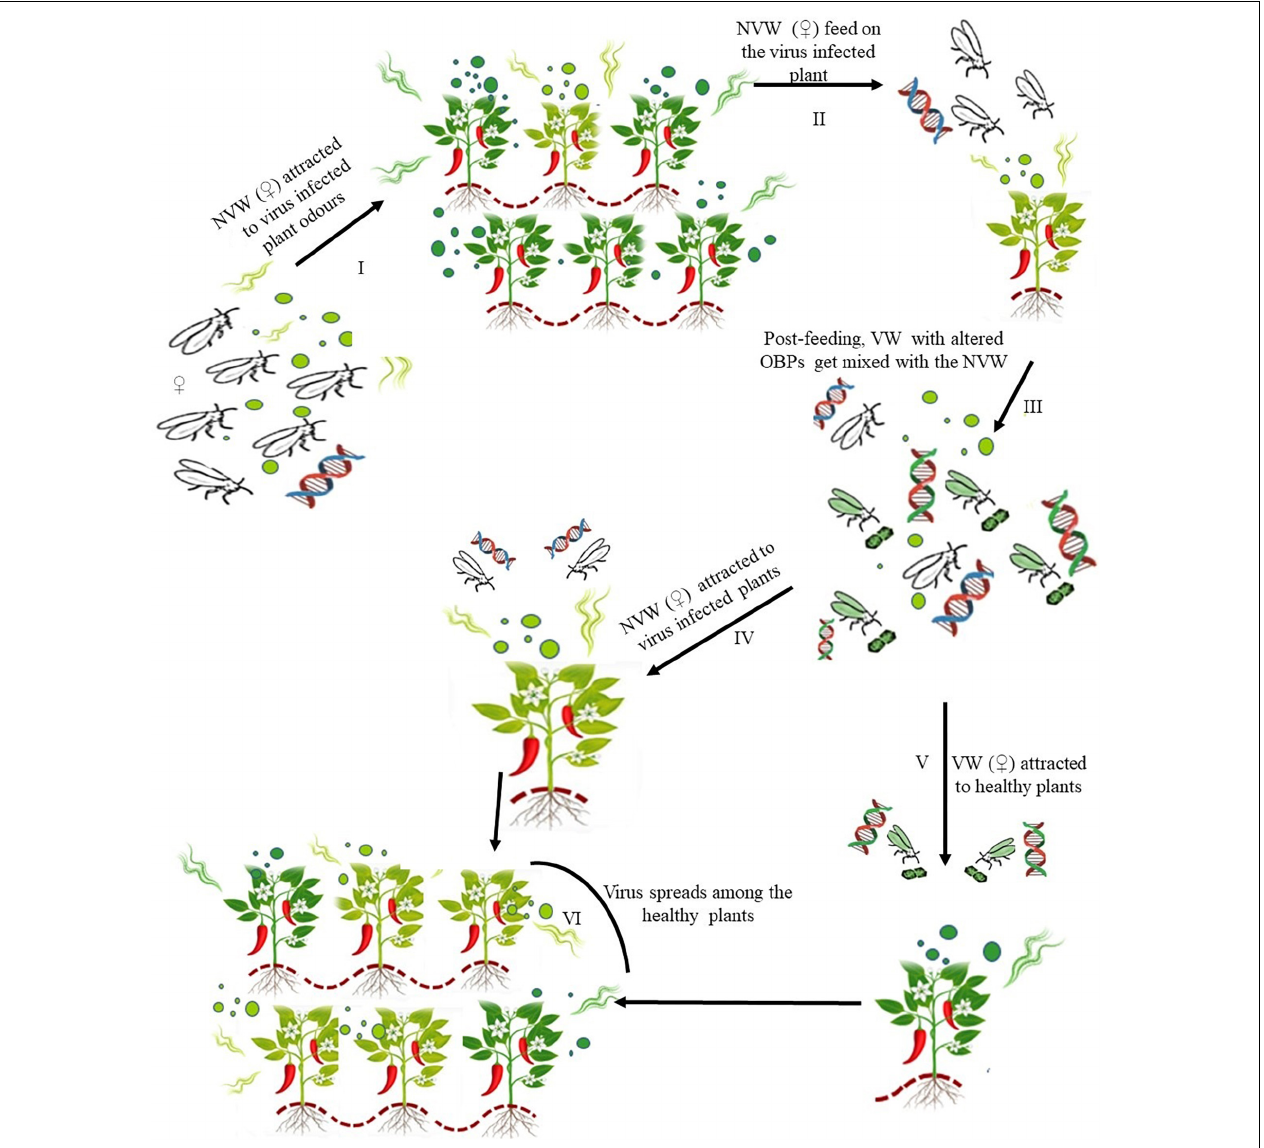
FIGURE 7 | Hypothetical representation showing how ChLCV spreads among the plants by manipulating virus infected plant odors and influencing the host location behavior of viruliferous (VW) and non-viruliferous (NVW) whiteflies.